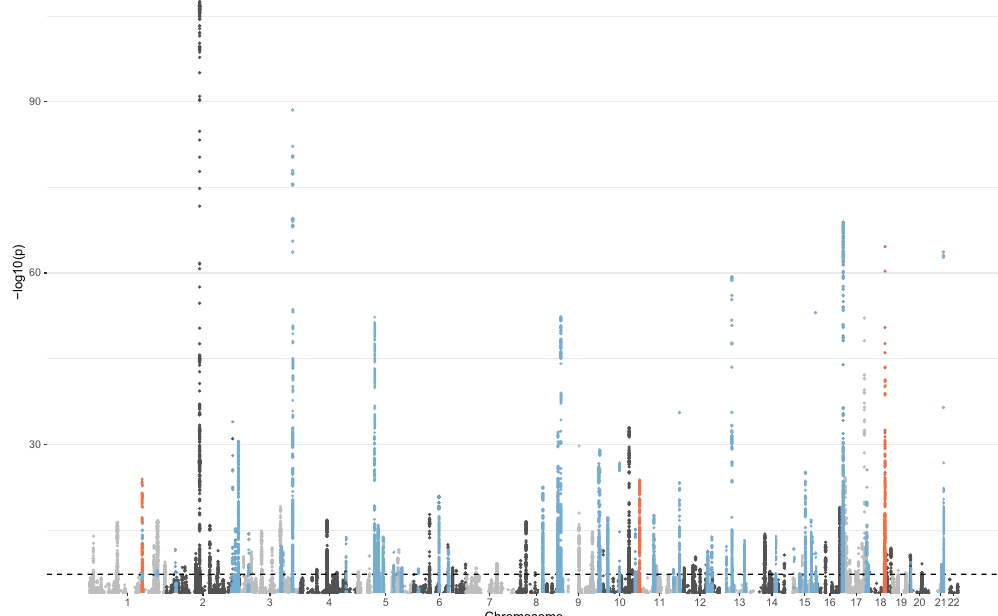
Fig. 1 Manhattan plot of the corneal resistance factor GWAS in UK Biobank white-British participants ( n = 76,029). The genome-wide signi fi cant threshold ( P value = 5 × 10 − 8 ) is displayed by the horizontal dotted black line. Only variants with P value < 0.001 are represented. Genomic risk loci overlapping known central cornea thickness and Fuchs corneal dystrophy loci are indicated in blue and orange, respectively. The test statistics in fl ation factor λ gc, 1.147, is mostly due to polygenicity (ratio (LDScore intercept − 1)/(mean(chi2) − 1) = 14.7%; LDscore intercept = 1.057(SE =